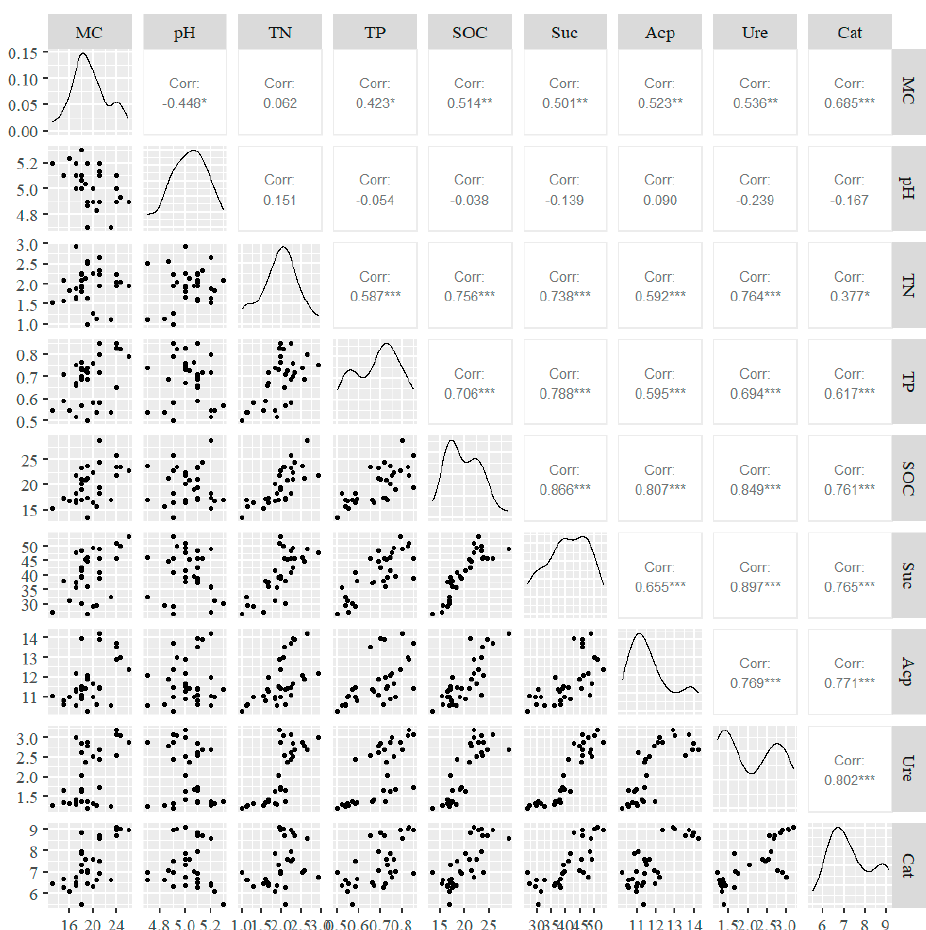
Figure 5. Correlation between soil nutrients and soil enzyme activities, * Significance of p < 0.05. ** Significance of p < 0.01.*** Significance of p < 0.001.